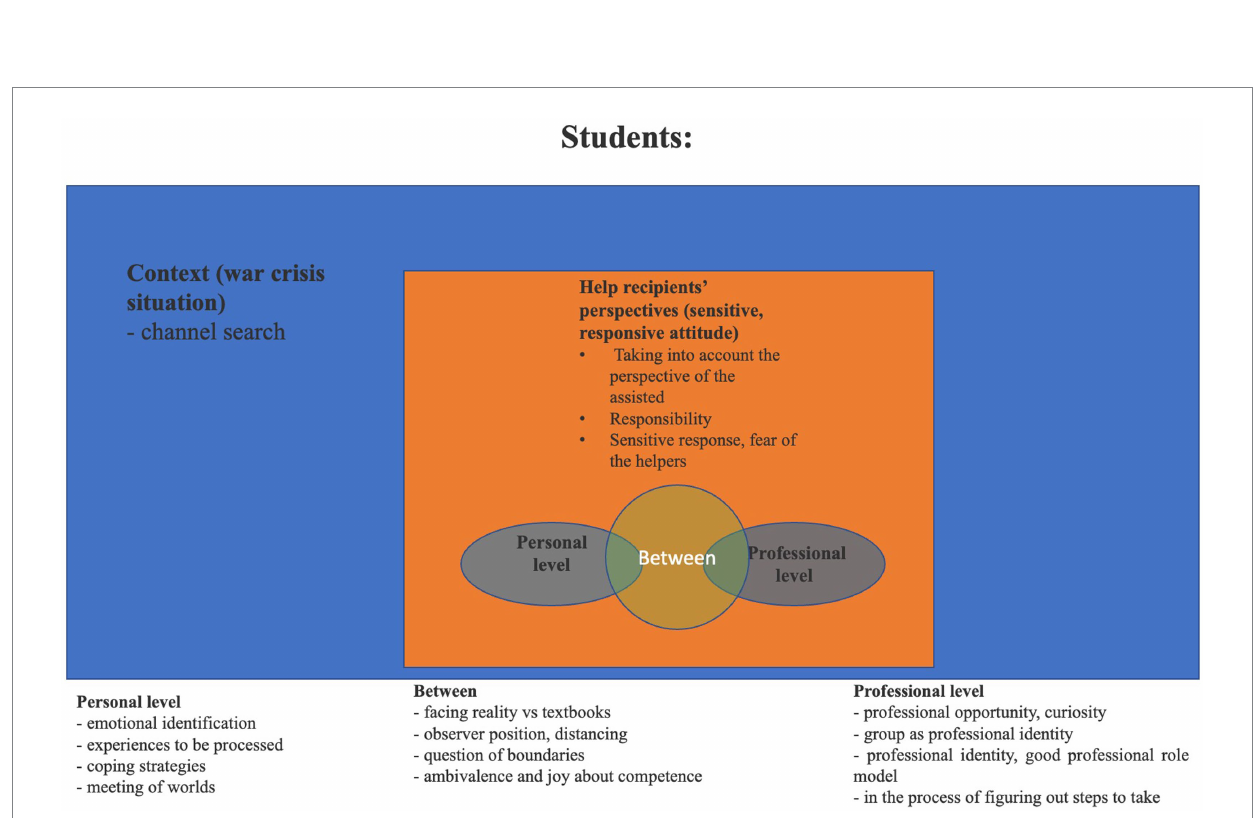
FIGURE 2 Results of the consensual content analysis—the categories established from the university students’ topics and the relationships among